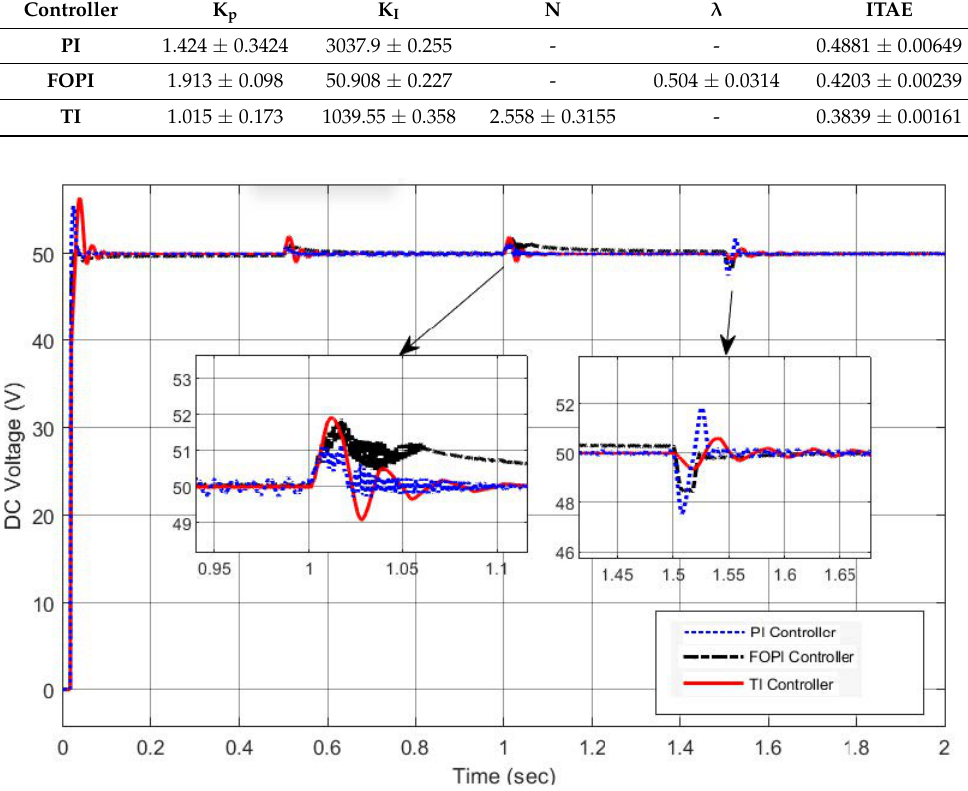
Figure 6. The DC bus voltage of the PV-HESS using the PI, FOPI, and TI controllers.